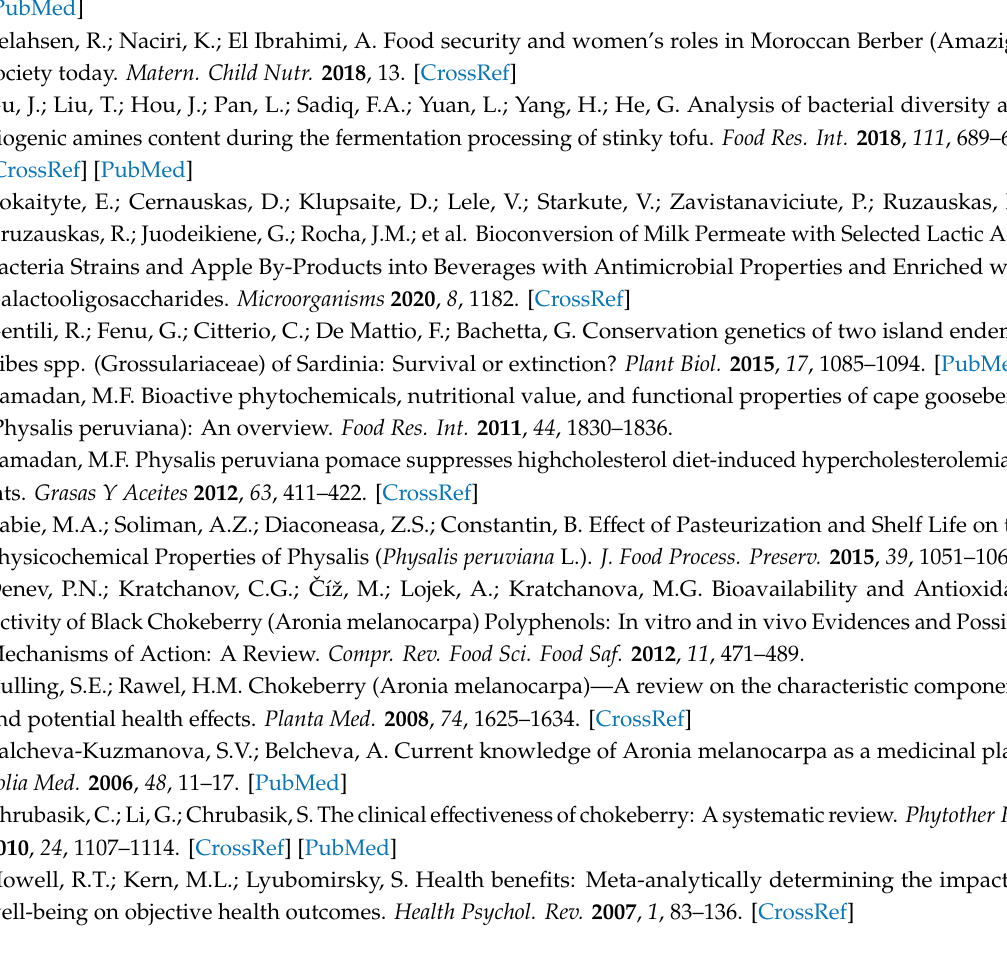
Table S1: Average values and standard deviations (Mean ± STDV) ( n = 3) of the acidity parameters, pH and total titratable acidity (TTA), and total lactic acid bacteria (LAB) viable counts in the milk permeate (MP) samples throughout fermentation ( t sampling = 0, 6, 12, 24, 48 h); Table S2: Average values and standard deviations (Mean ± STDV) ( n = 3) of the diameter of inhibition zones (mm) of the nonfermented milk permeate (MP) against 15 pathogenic and opportunistic bacterial strains; Table S3: Average values and standard deviations (Mean ± STDV) ( n = 3) of the antimicrobial activities of the nonfermented milk permeate (NFMP) against 15 pathogenic and opportunistic microbial bacterial in liquid medium ( + indicates pathogen growth; - indicates that pathogen growth was not